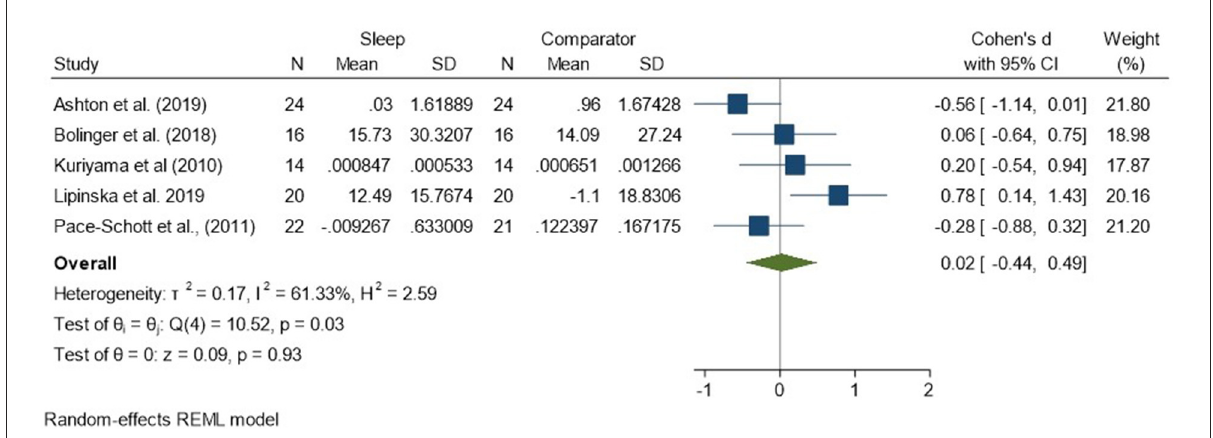
FIGURE4 Meta-analysis I: Physiological outcomes in response to negative stimuli – changes across a period of sleep compared to across a period of waking ( K = 5, N = 155).